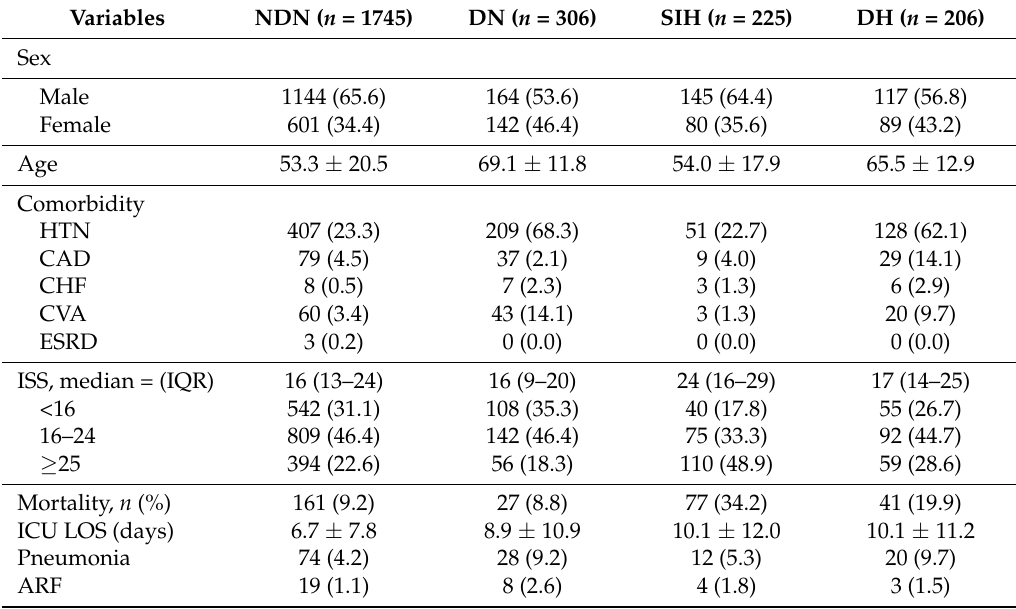
Table 1. Epidemiological characteristics of the